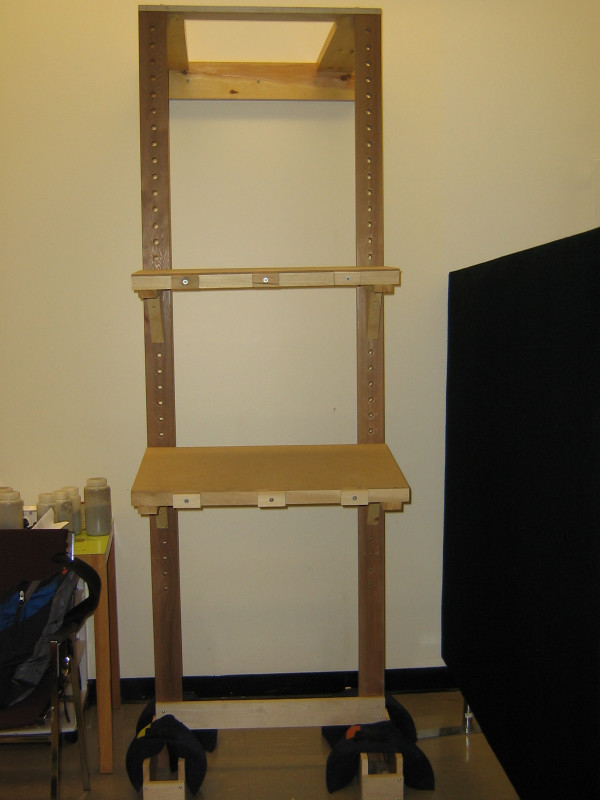
Wooden Version of the FIT-HaNSA.